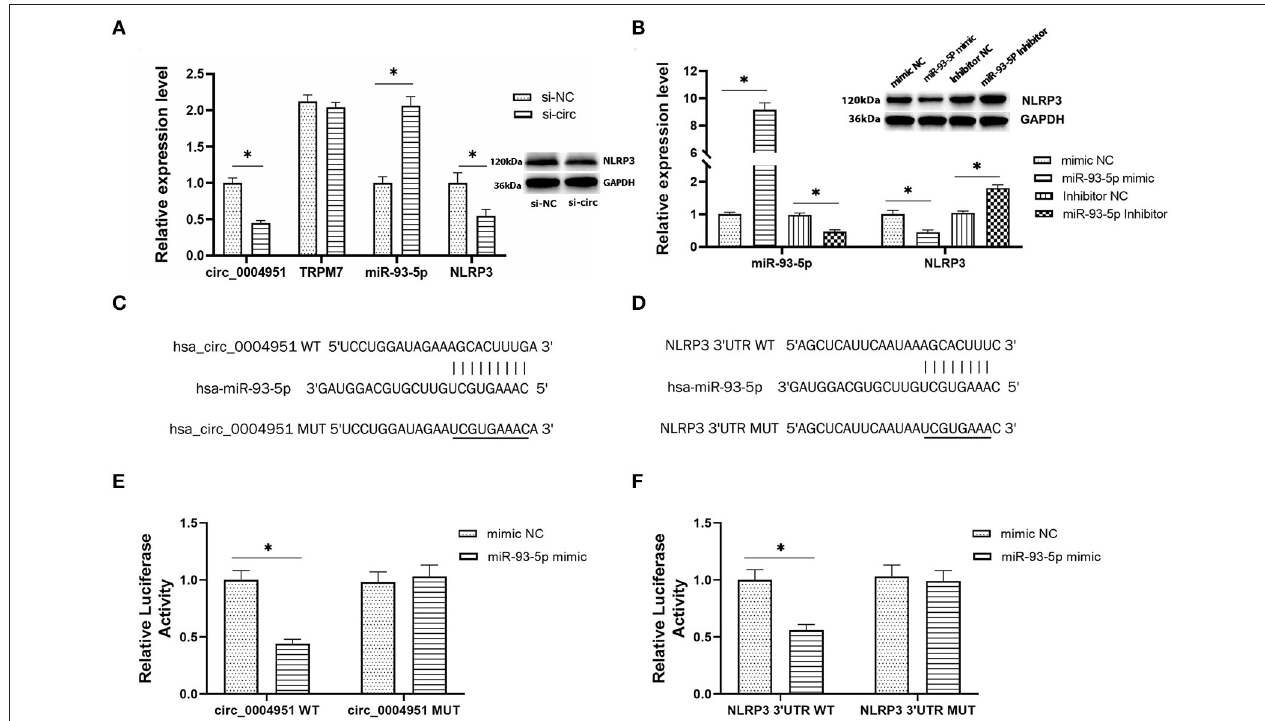
FIGURE 4 | The regulatory relationship between circ_0004951, miR-93-5p and NLRP3. The expression of circ_0004951, parental gene TRPM7, miR-93-5p and NLRP3 after knockdown of circ_0004951 (A) . MiR-93-5p mimic and miR-93-5p inhibitor upregulated and downregulated expression of miR-93-5p and NLRP3, respectively (B) . Bioinformatics analysis showed the adsorption and binding sites for miR-93-5p in circ_0004951 (C) , and seed region sites of NLRP3 3 ′ UTR bound to miR-93-5p (D) . Luciferase reporter assay results showing relative luciferase activities after co-transfection of construct containing wt or mut of circ_0004951 and miR-93-5p mimics or inhibitors (E) . Luciferase reporter assay results showing luciferase activities after co-transfection with the miR-93-5p mimic containing either wt or mut of NLRP3 (F) . NLRP3, NLR pyrin domain containing 3; HK2, human renal tubular epithelial cell line; 3 ′ -UTR, 3 ′ -untranslated region. Values are expressed as mean ± SD. * p < 0.05 vs. control.